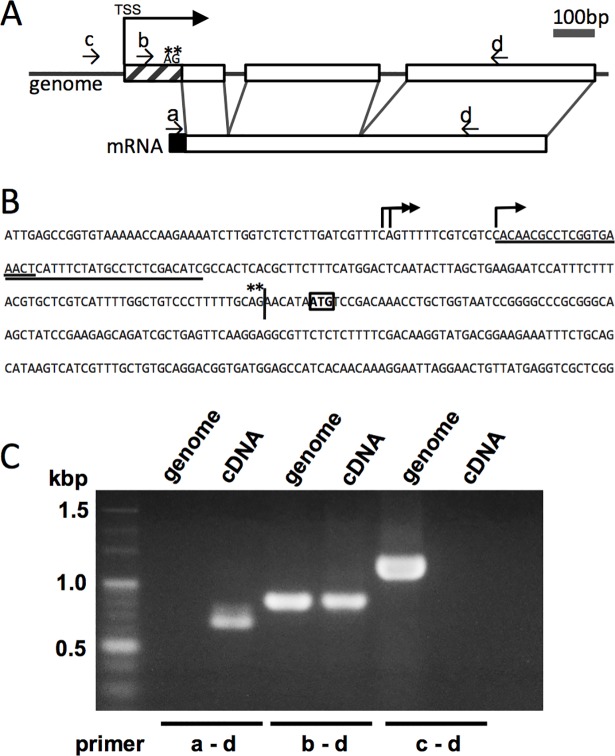
Structure of the calmodulin gene of P. micropora.A. Schematic model of the calmodulin gene and its mRNA. Primers used for PCR- and RT-PCR analyses are shown by small arrows a, b, c, and d. The outron and spliced leader are shown as hashed and black boxes, respectively. The thick arrow indicates the transcription start site (TSS). B. Genomic sequence of the calmodulin gene, with the ATG initiation codon boxed. The junction of the outron and exon is indicated by the vertical bar. TSS and the pyrimidine rich region are indicated by the thick arrow and dots, respectively. The underlines show the position of primer b (consisting of two nested primers). C. PCR profiles of the calmodulin gene using genomic and cDNA templates.